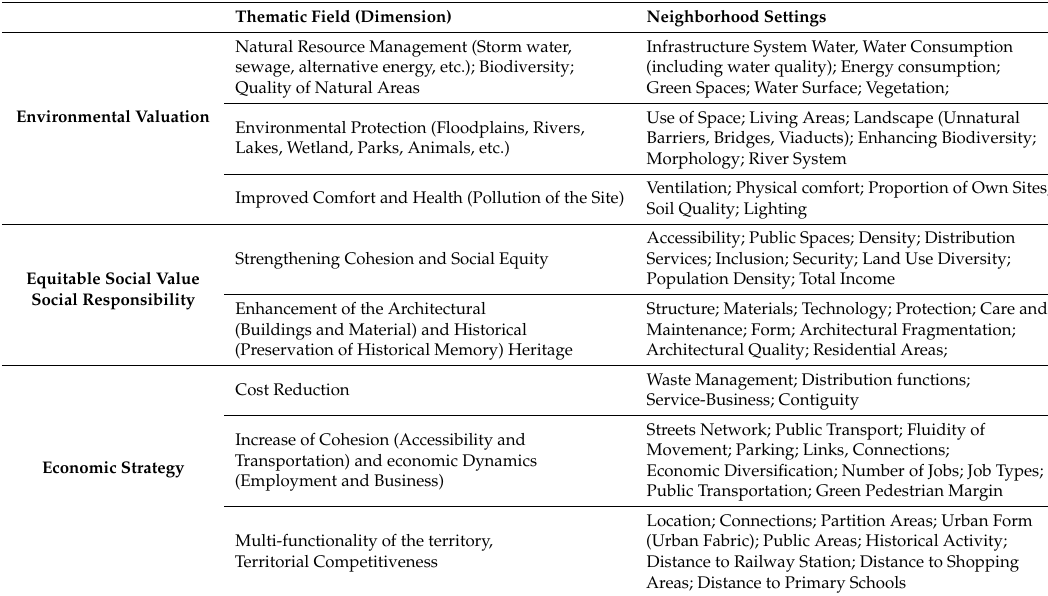
Table 8. Thematic fields and neighborhood setting in